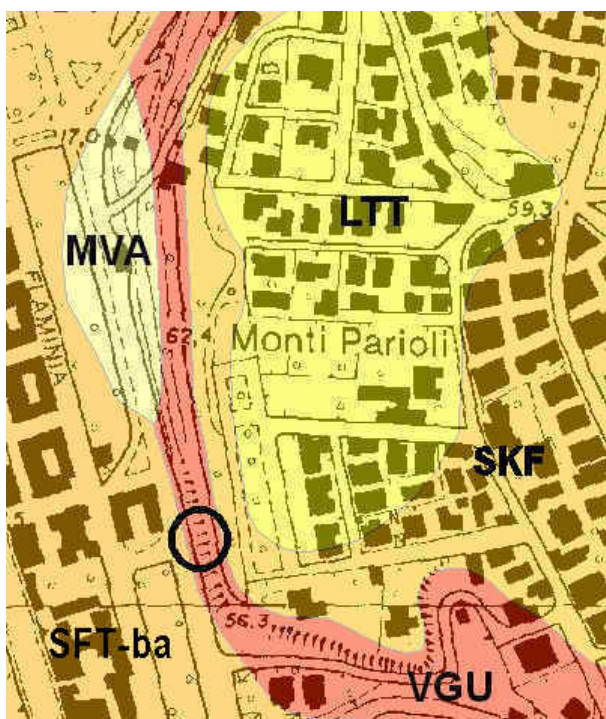
Fig. 5. Geological map of Monti Parioli area, from sheet 374 “Roma”, 1: 50000 scale, Geological Map of Italy. The black circle indicates the location of the study event. Legend. SFT-ba: Tevere R. alluvial deposits (Holocene); LTT-SKF: Tufi Stratificati Varicol- ori di La Storta and Tufi Stratificati Varicolori di Sacrofano (Mid- dle Pleistocene – Upper Pleistocene); VGU: Valle Giulia Formation (Middle Pleistocene); MVA: Monte Vaticano Formation (Lower